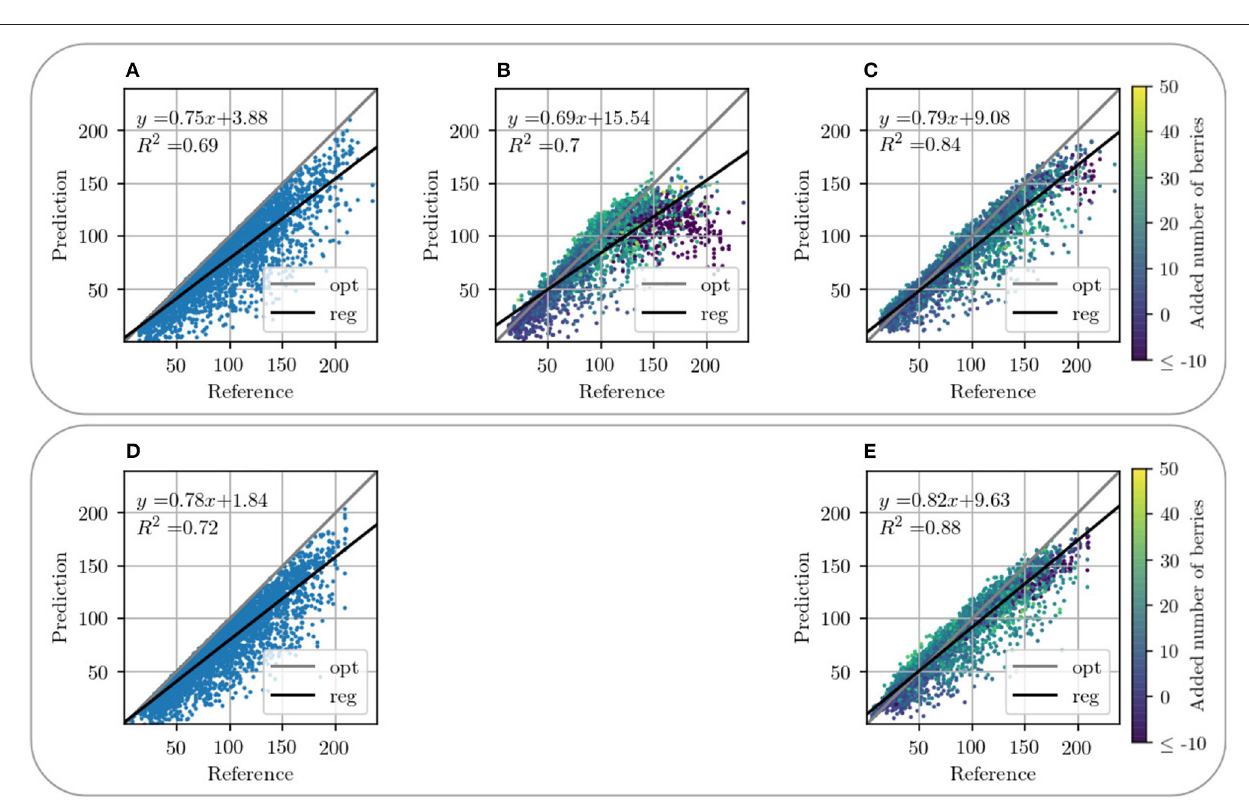
FIGURE 10 | Graphical visualization of the berry counting by a R 2 -Plot. Row 1 illustrates the results for VSP defoliation while row 2 illustrates the results for SMPH defoliation. (A,D) Show the input of the occluded domain and (B,C,E) of generated berries in the non-occluded domain. Shown is the relation between the generated x x output non in relation to reference non for data with input channel B (B) and GB (C,E) . The coloration of the data points in the plots (B–D) indicates the added e number of berries compared to the non-occluded domain.